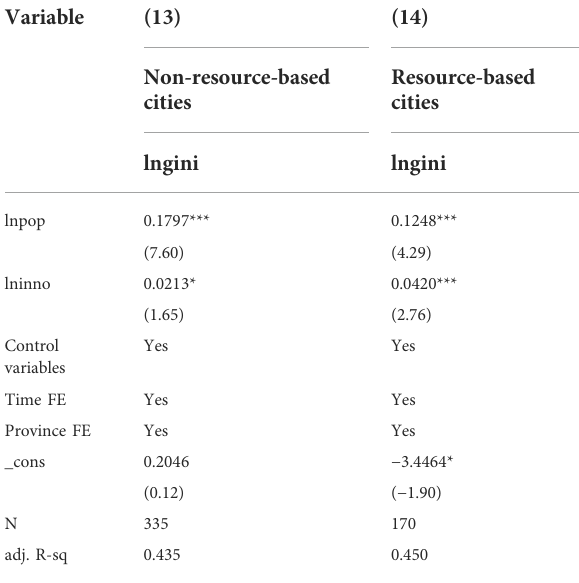
TABLE 6 Regression results at the urban level (based on Sustainable Development Plan for Resource-based Cities in China).